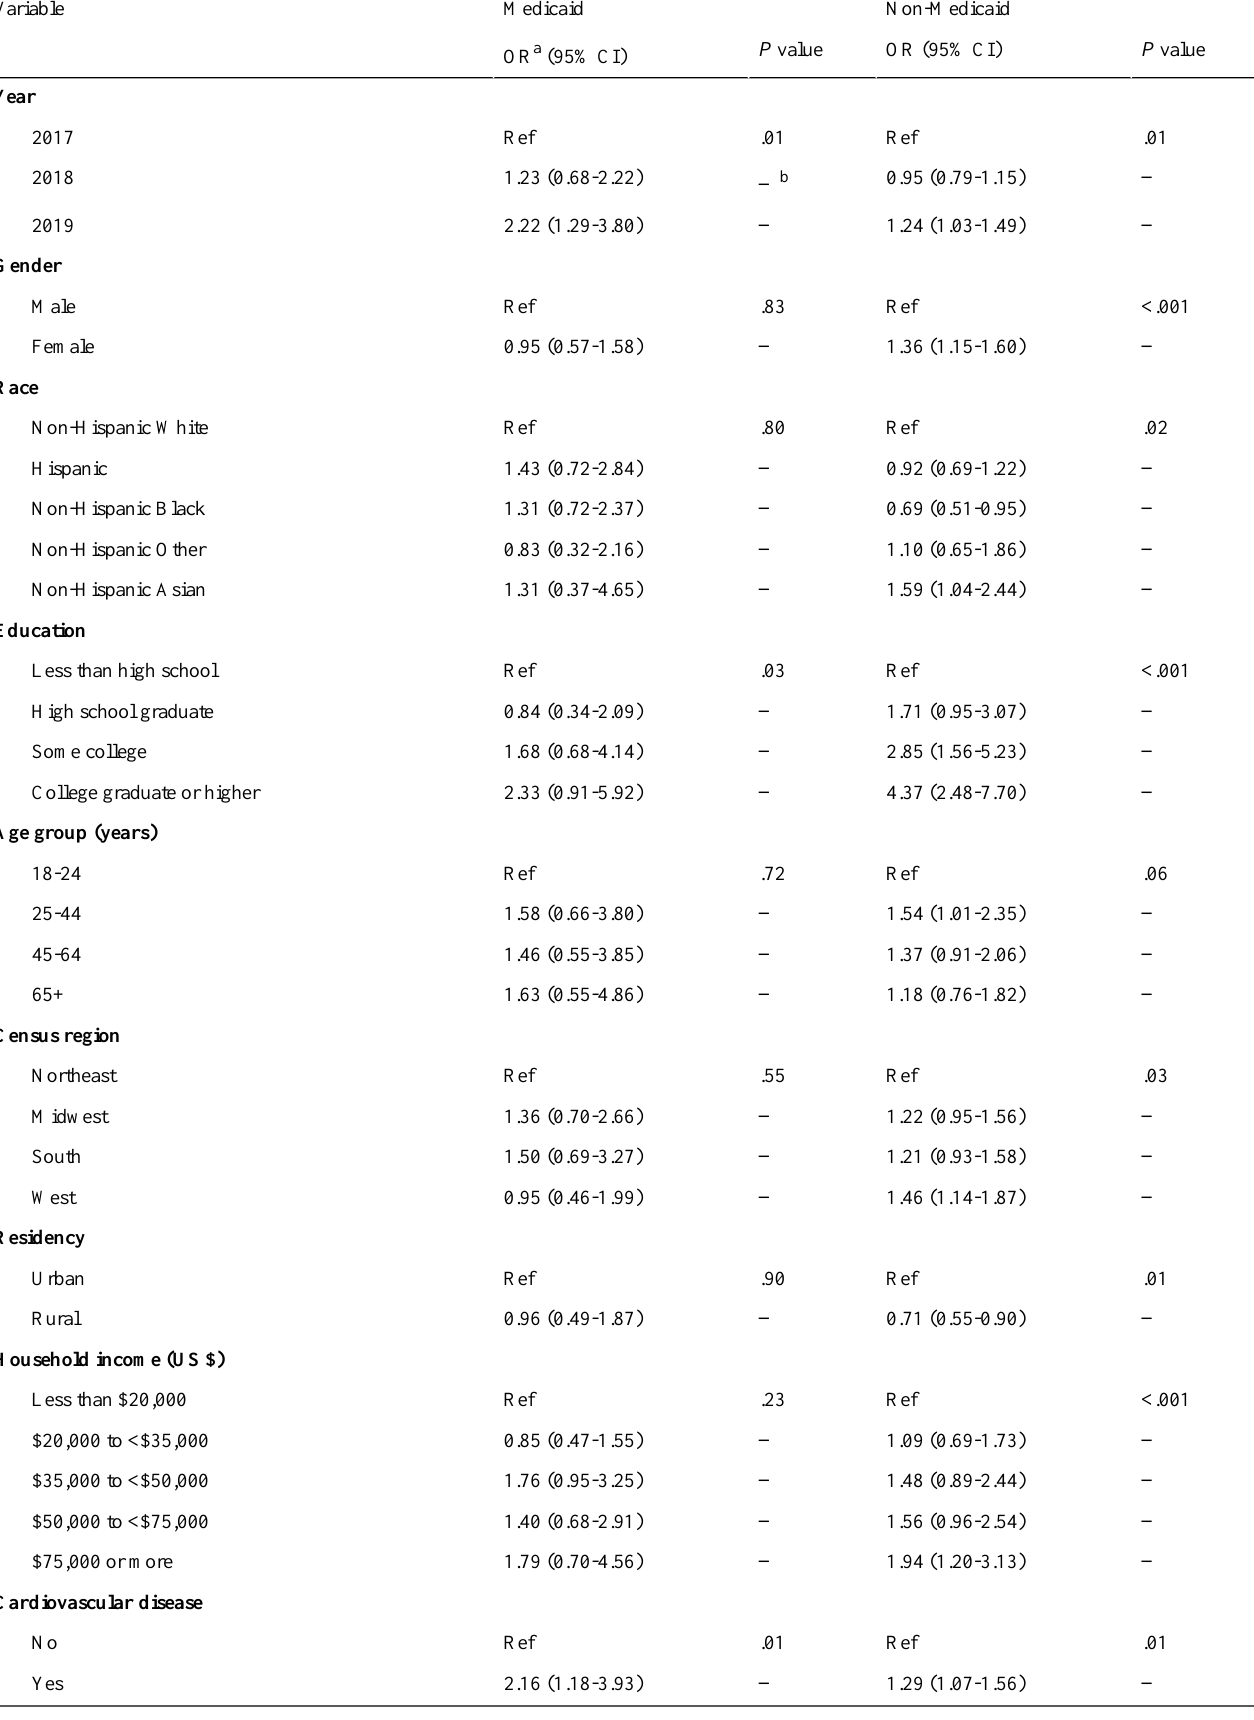
Non-Medicaid Medicaid